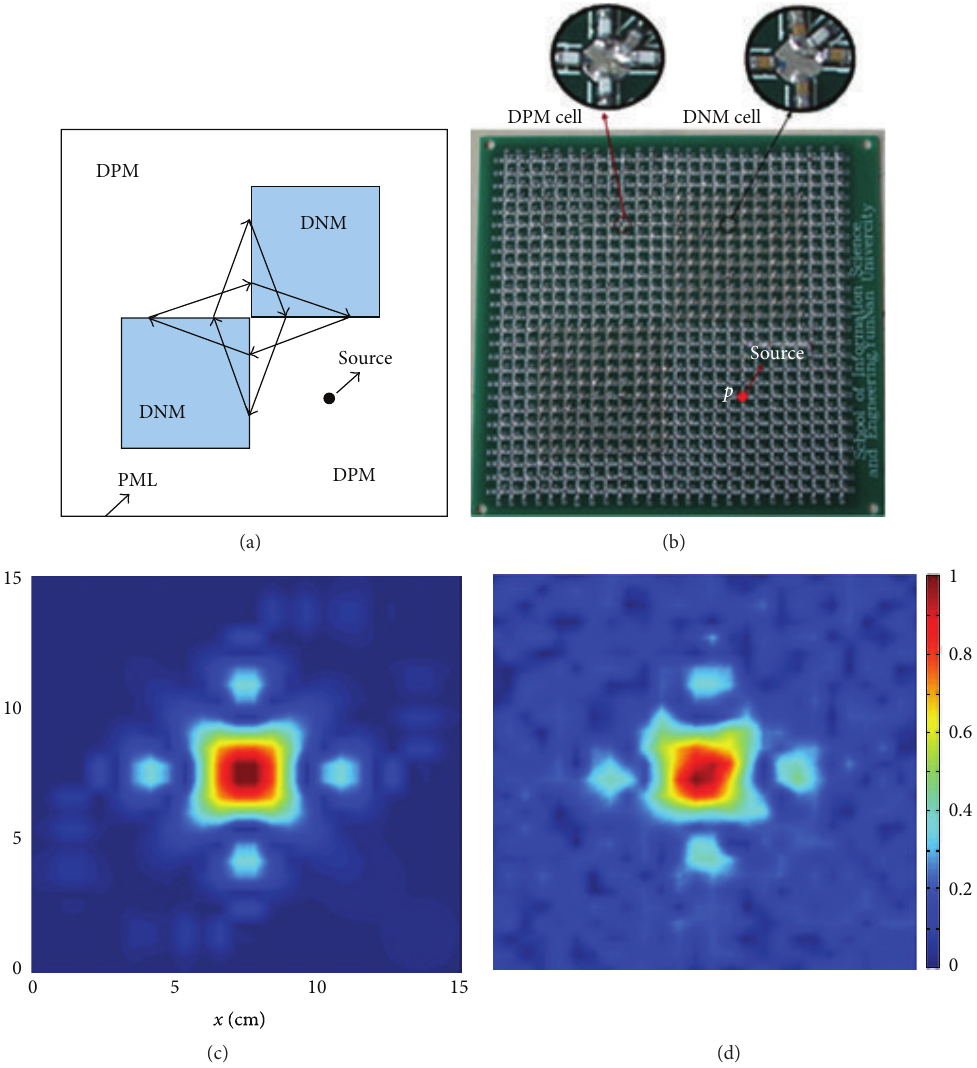
Figure 18: (a) Schematic structure of the open resonator consisting of two homogeneous negative refractive index metamaterial squares. (b) PhotographofthemetamaterialopenresonatorbasedonL-Cnetwork.(a)Simulationand(b)measurementresultsofnotevoltagedistribution [28].